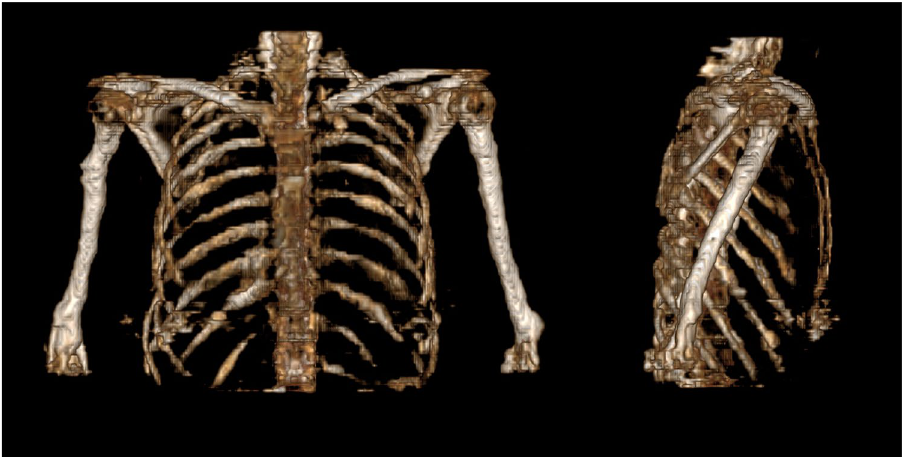
Figure 5. Three-dimensional VR images of bones obtained via synthesised CT; in general, it is extremely difficult or almost impossible to synthesise these kinds of VR images of bone from MR images. The 3D animation movie is attached as the Supplementary material.